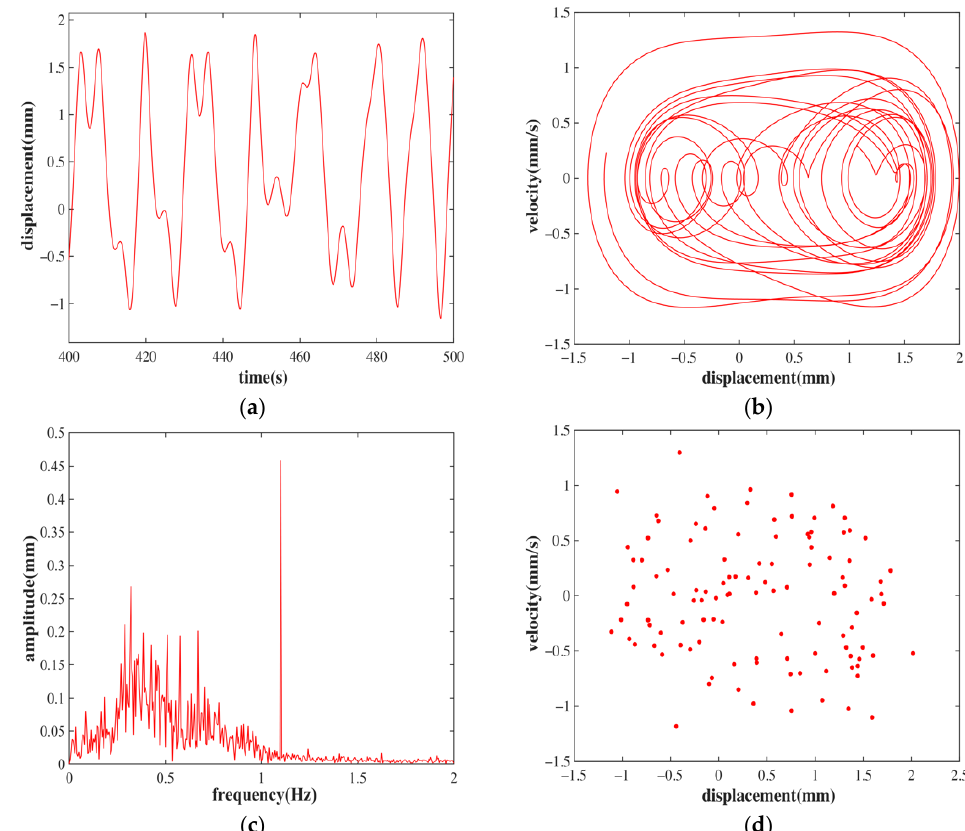
Figure 17. Nonlinear response of the GMA system at δ = − 0.18: ( a ) Time domain waveform diagram; ( b ) Phase trajectory curve; ( c ) Amplitude spectrum; ( d ) Poincaré diagram.